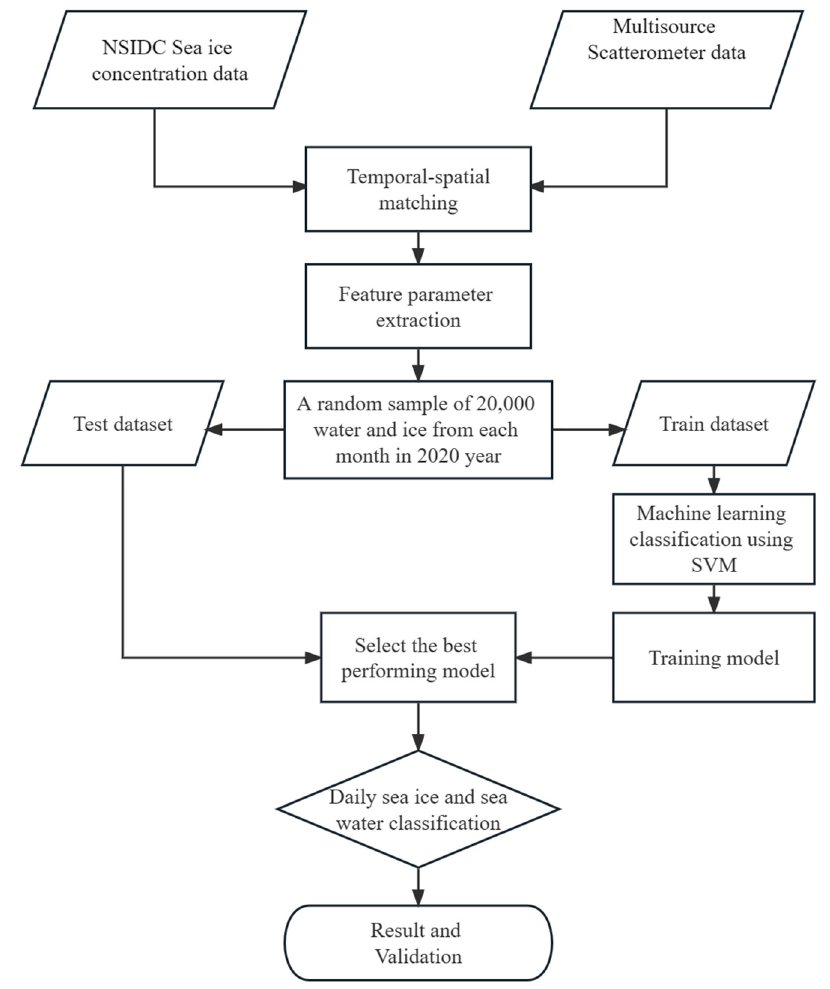
Figure 3. The flowchart of sea ice monitoring based on SVM classifier with multisource scatterom- eter